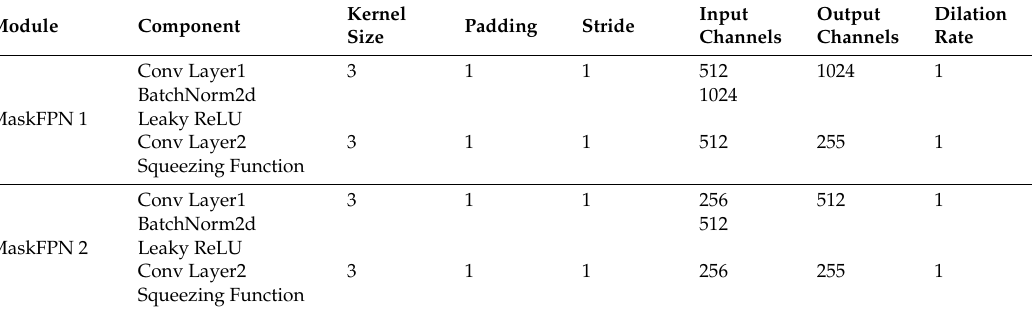
Table 1. MaskFPN parameter settings.